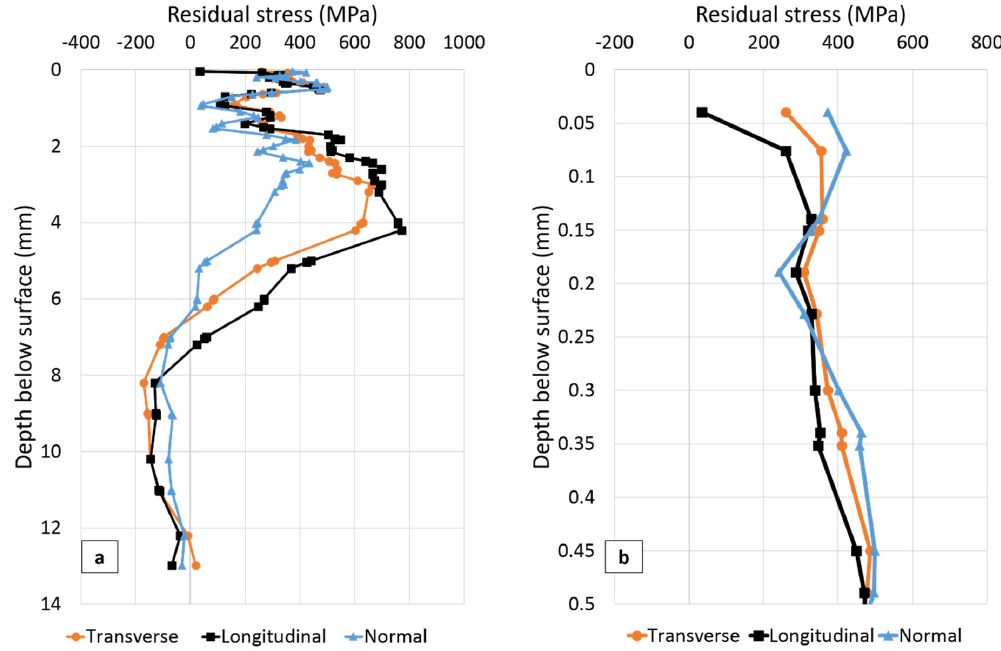
Figure 8. ( a ) Residual stresses as function of distance below the plate surface at the weld toe on the first welded side (FS-WT in Figure 4); ( b ) Residual stress from surface to 0.5 mm below the surface. In Figure 6, the point closest to the surface for which residual stress was measured is 120 µ m below the surface. The experimental uncertainties vary from about ± 140 MPa close to the weld toe surface to ± 30 MPa at greater